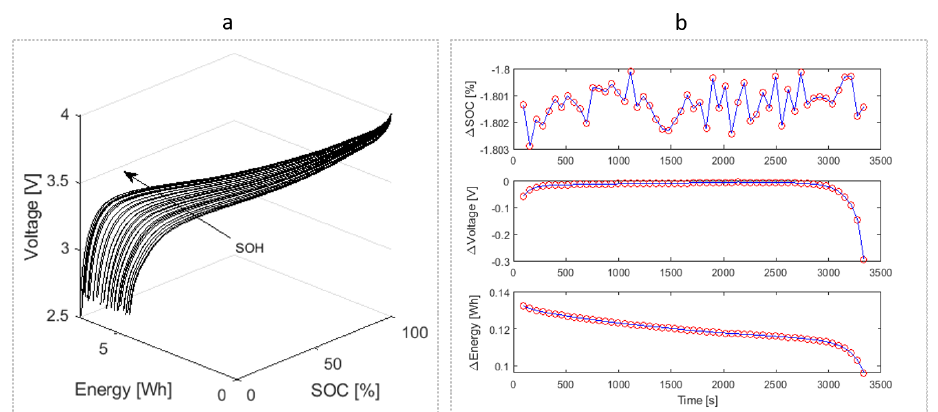
Figure 5. ( a ) A three-dimensional plot of SOC–capacity–voltage for a constant current discharge profile. Each curve represents a single cycle. The arrow is the reverse direction of aging across cycles. ( b ) The corresponding feature variables obtained as variations of SOC, capacity, and